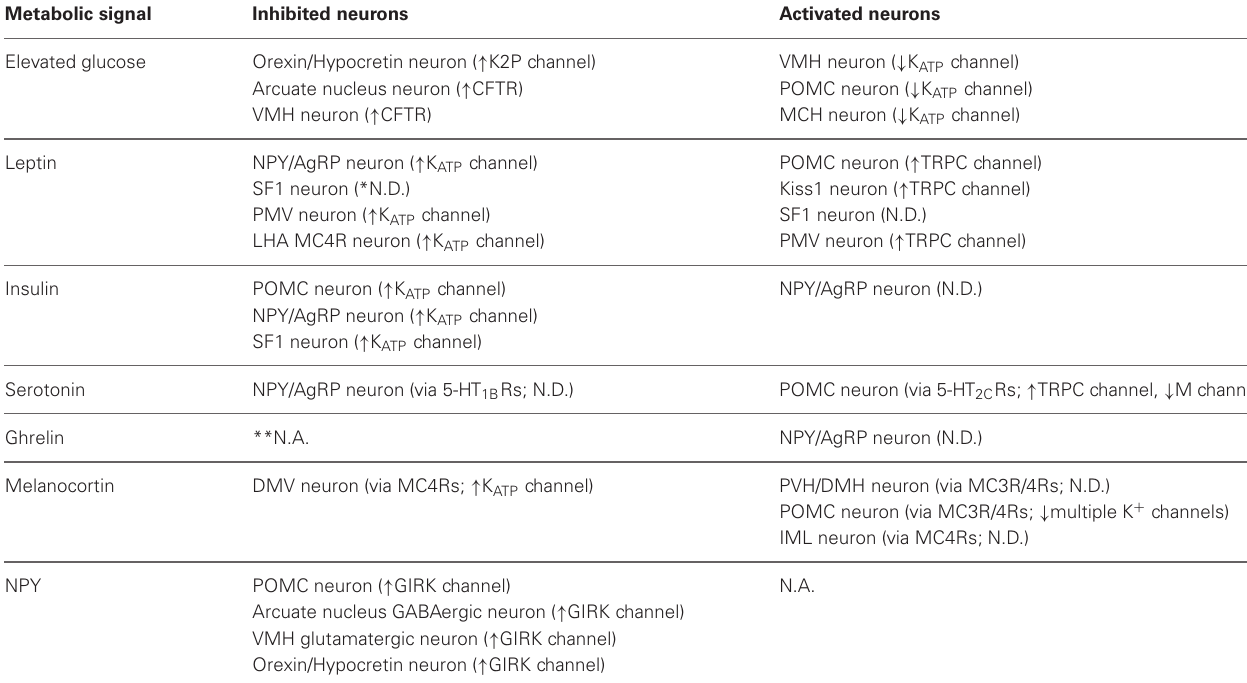
Table 1 | Acute cellular effects of metabolic signals in the CNS. Metabolic